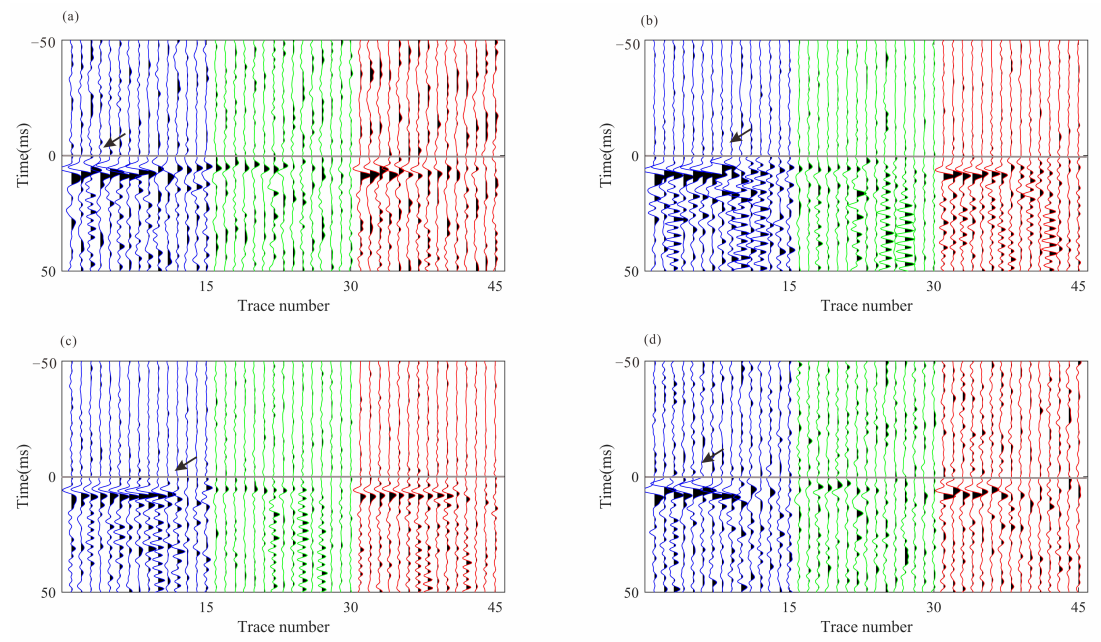
Figure 11. P-waves of four microseismic events recorded by 15 receivers after moveout correction. The horizontal gray line represents P-wave arrivals. ( a – d ) are P-wave recordings from the four events in Figure 10. Blue, green, and red lines represent rotated x-, y-, and z- components, respectively. The arrows indicate the local inconsistencies between